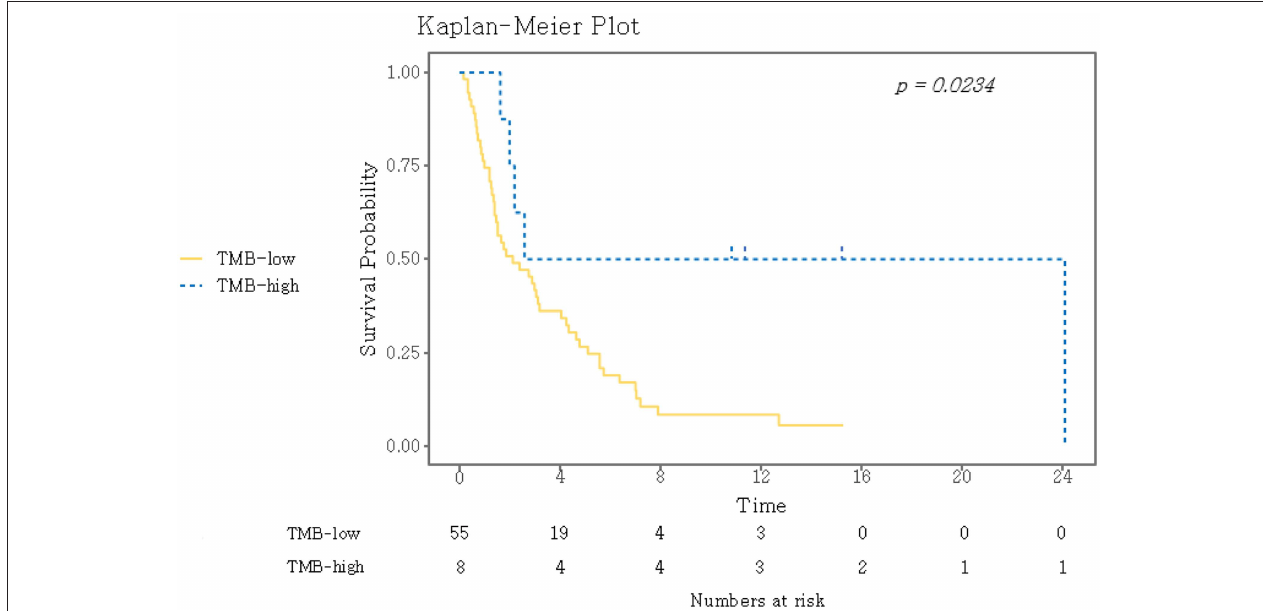
FIGURE 3 | Kaplan–Meier curves for PFS for the dichotomized TMB groups. A log-rank test was used to compare the two groups. TMB, tumor mutational burden.